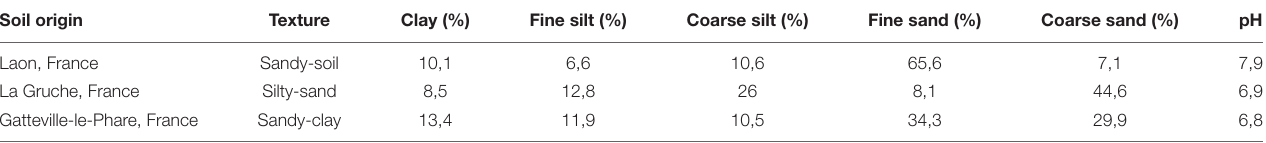
TABLE 3 | Characteristics of the soils used in the pot experiments with the respective sites where the soils were collected. Soil origin Texture Clay (%)